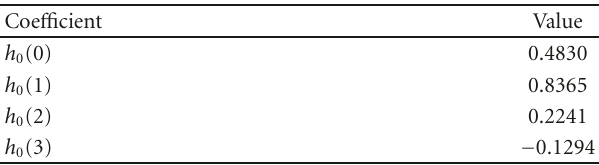
Table 4: Daub-2 low-pass filter coe ffi